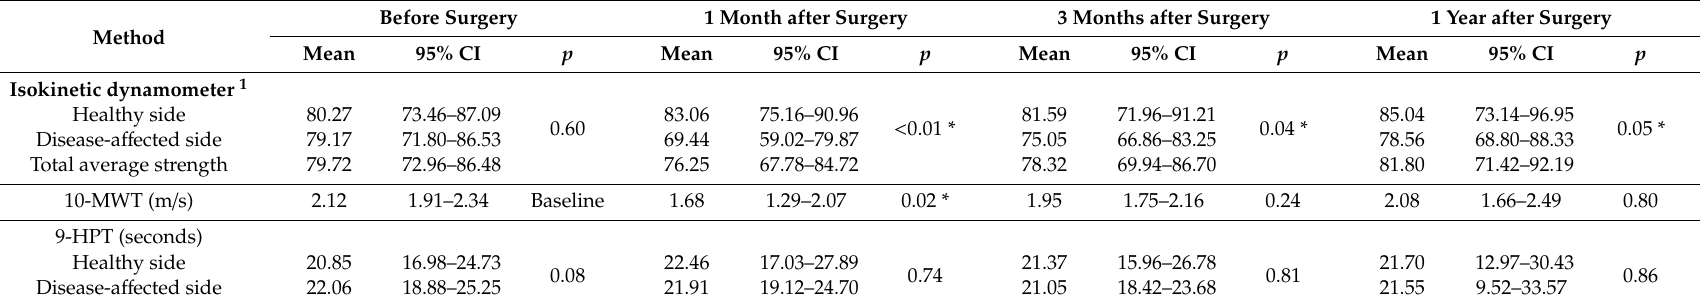
Table 4. Functional outcome measured by isokinetic dynamometer, the 10-m walk test (10-MWT), and the 9-hole peg test